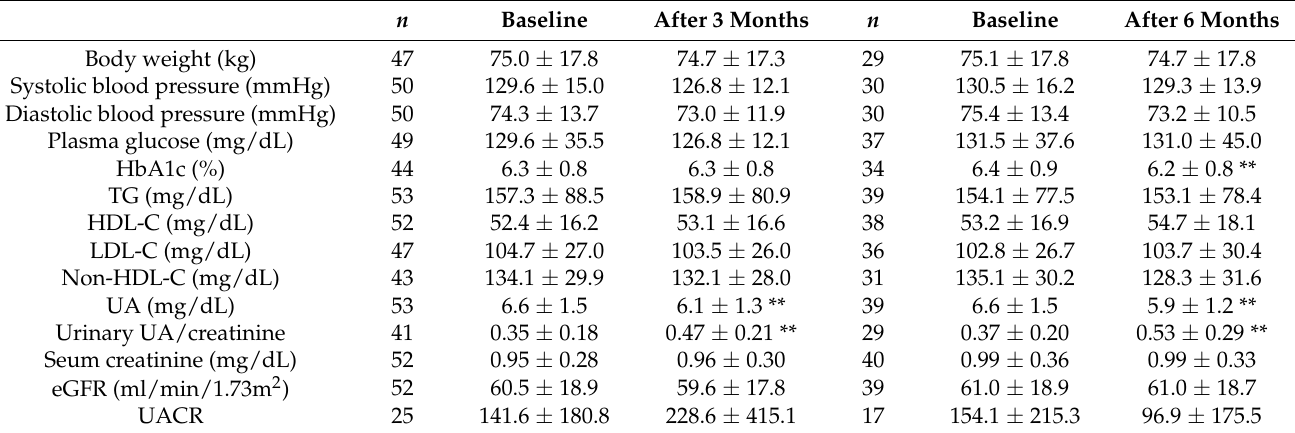
Table 11. Changes in metabolic parameters after the start of dotinurad in patients who had not taken SGLT2 inhibitors ( n = 59).